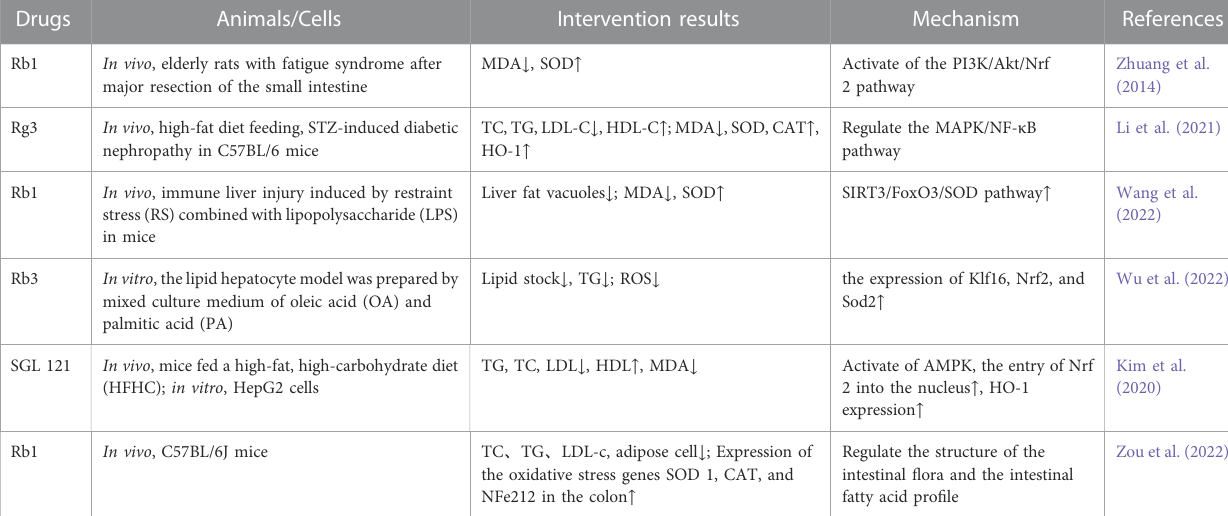
TABLE 2 Ginseng and its active components protect organs and tissues by increasing the activity of antioxidant enzymes to reduce oxidative stress. Drugs